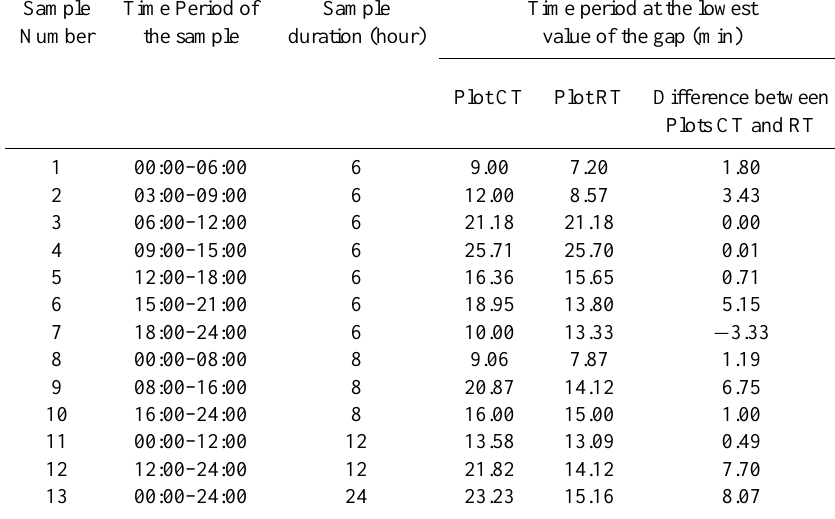
Table 5. Time period of the lowest value of the spectral gap according to the daytime period, the sample size and the experimental plot Sample Time Period of